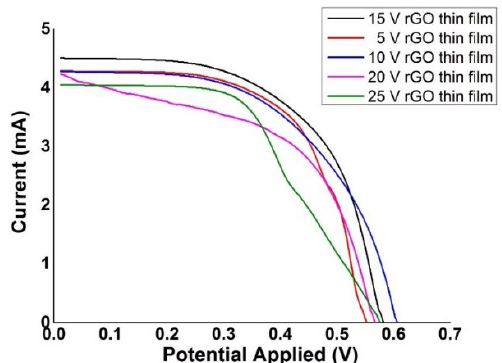
Figure 10. DSSC performance of rGO thin-film photoanode produced from electrochemical reduction in various voltages.